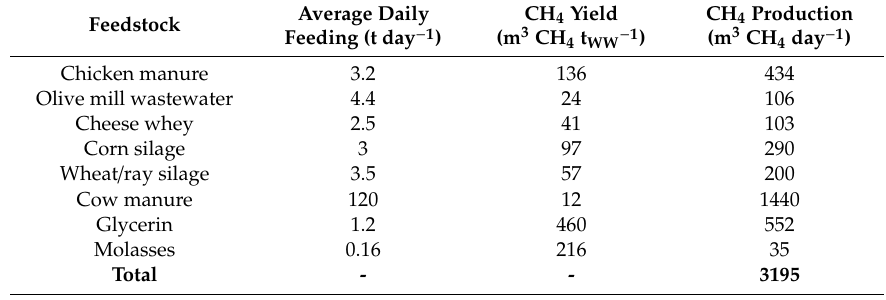
Table 2. Estimated daily CH 4 production based on the feeding feedstocks.